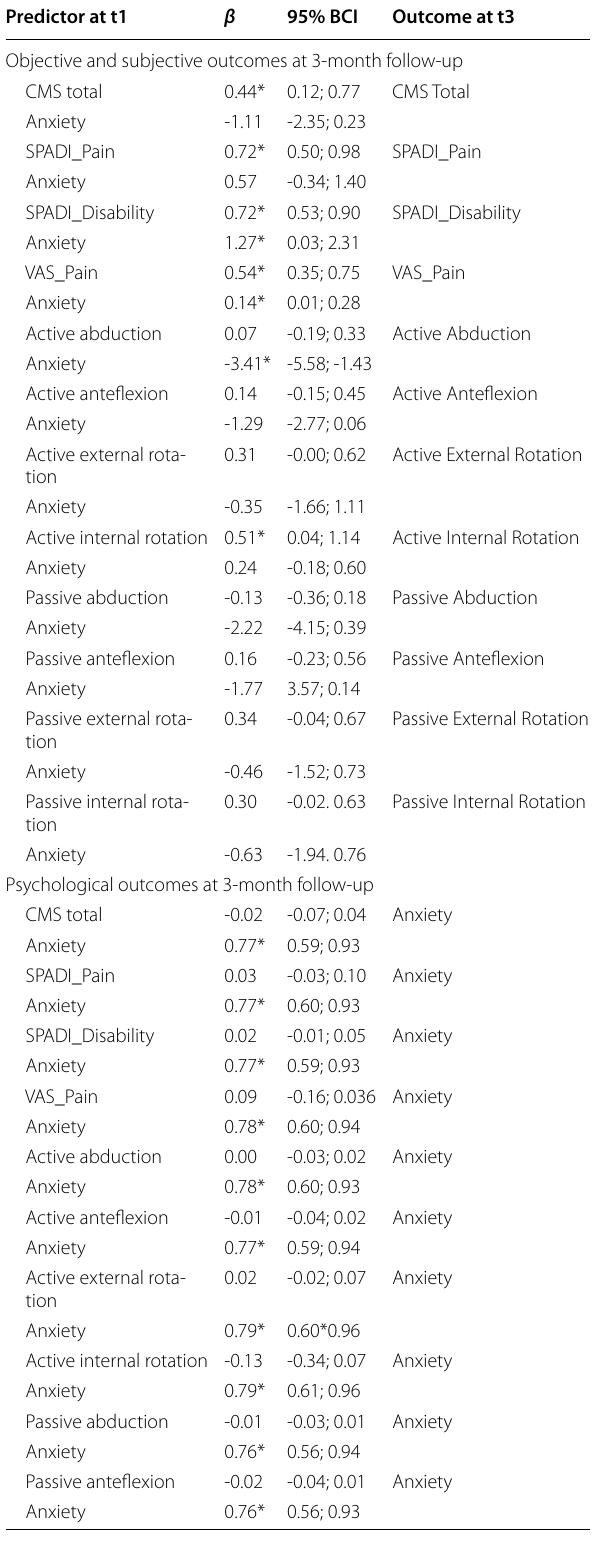
Table 4 The reciprocal effects between objective and subjective outcomes of hydrodilatation and anxiety Predictor at